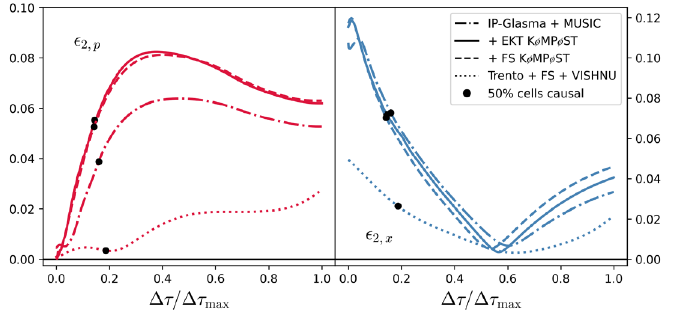
Figure 1. From top to bottom: the TFV scenario and the three IKM scenarios (no KøMPøST, free- streaming KøMPøST, EKT KøMPøST). Colors correspond to the following cell classifications: cer- tainly causal (blue), certainly acausal (red), and purple (indeterminate). Taken from Ref. [5].